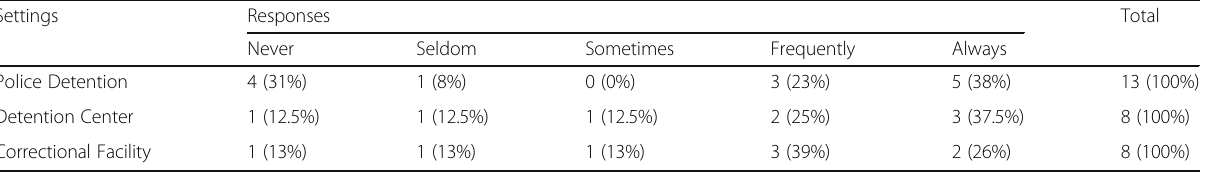
Table 2 Paralegals check on the health condition Settings Responses